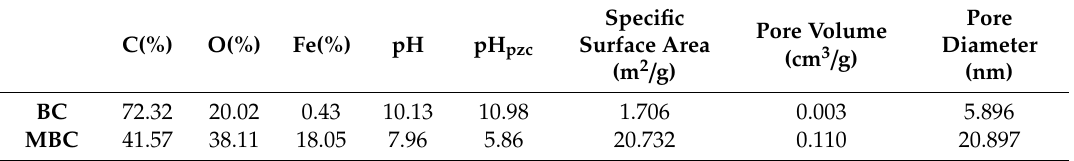
Table 2. Physico-chemical characteristics of biochar (BC) and magnetic biochar